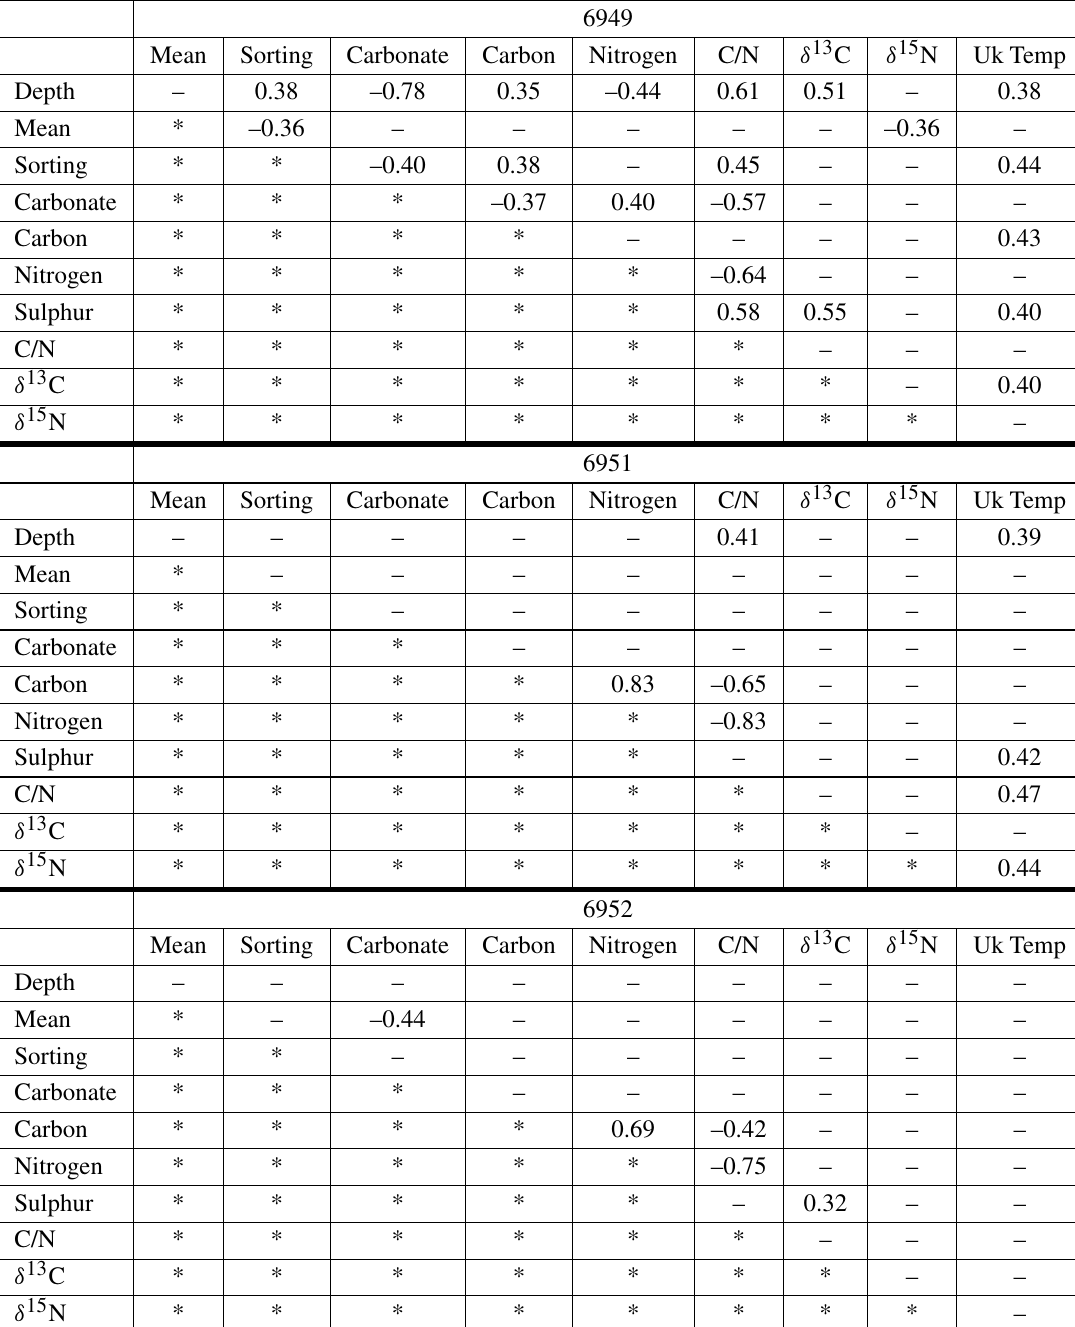
Kendall- τ correlations among the sedimentological parameters. Only significant correlations ( α ⇐ 0 . 100 ) are